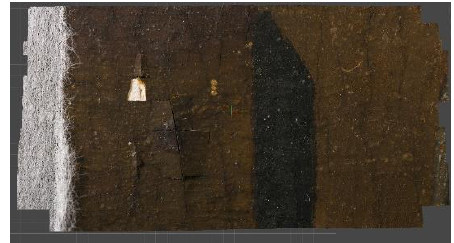
Figure 6. St. Constantine and Helen: textured 3D model reconstructed using macro photogrammetry (Area 1)